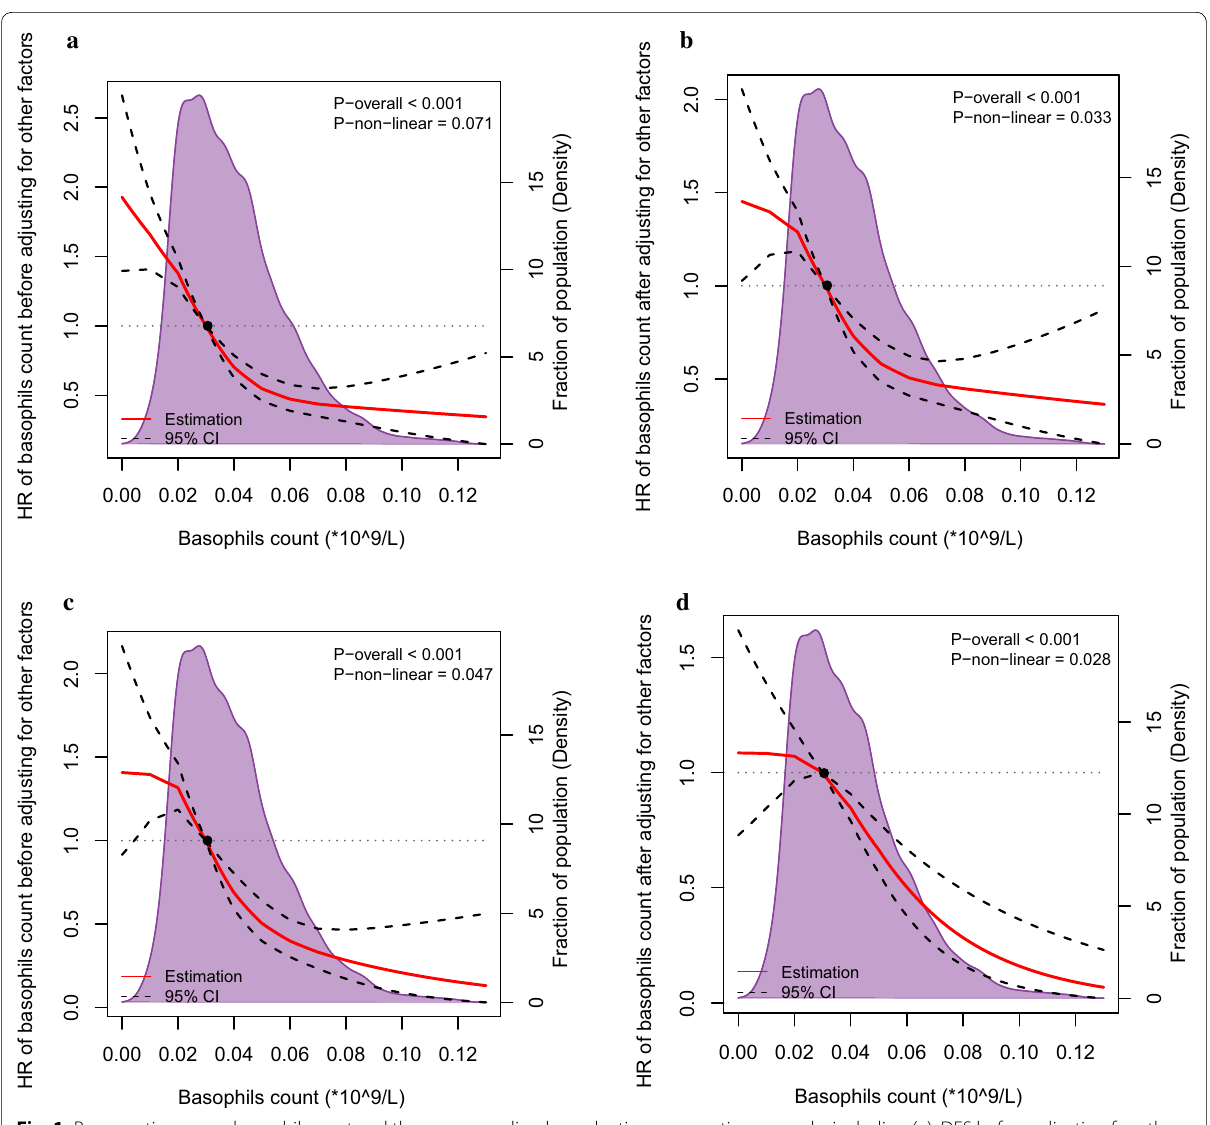
Fig. 1 Preoperative serum basophil count and the corresponding hazard ratios on a continuous scale, including ( a ). DFS before adjusting for other prognostic factors; ( b ). DFS after adjusting for other prognostic factors; ( c ). OS before adjusting for other prognostic factors; ( d ). OS after adjusting for other prognostic factors. Analyses were conducted using restricted cubic splines, with hazard ratios and 95% confidence intervals from univariate to multivariate Cox proportional hazards regression. The basophils count of 0.03*10 9 /L was chosen as the reference. The purple area indicated the distribution of concentration of the basophils